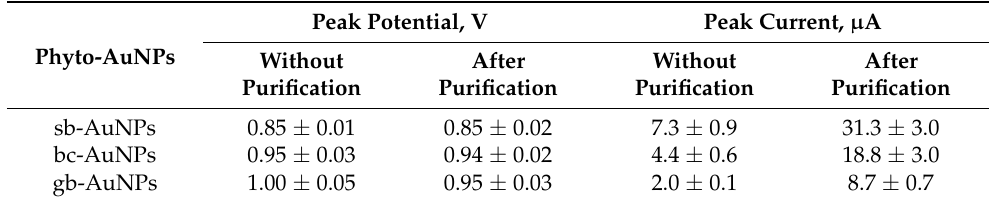
Table 1. The impact of washing gold sols synthesized with 0.75 mL of plant extracts (pH 6) on phyto-AuNPs electro-oxidation parameters. Peak Potential, V Peak Current, µ A Phyto-AuNPs Without After Without After Purification Purification Purification